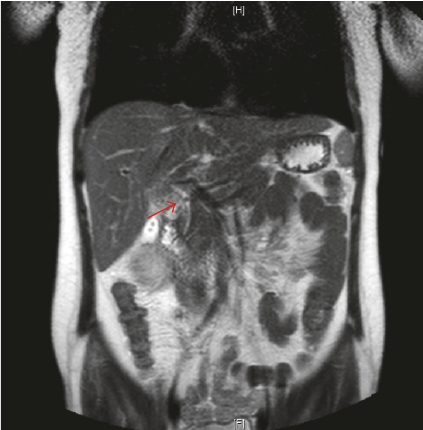
Figure 1: MRCP showing a 4 mm (arrow) obstructing gallstone in the distal common bile duct.